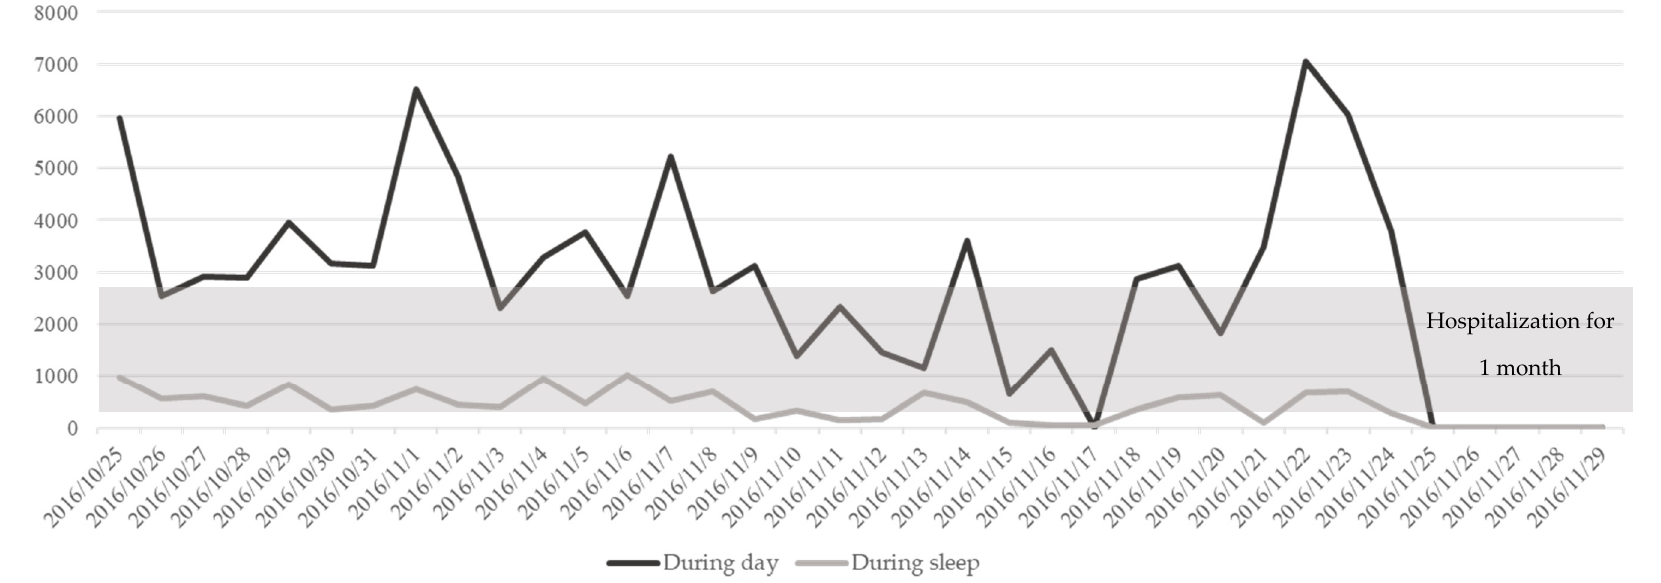
Figure 4. Changes in total indoor activities of Participant C (F/93-year-old)